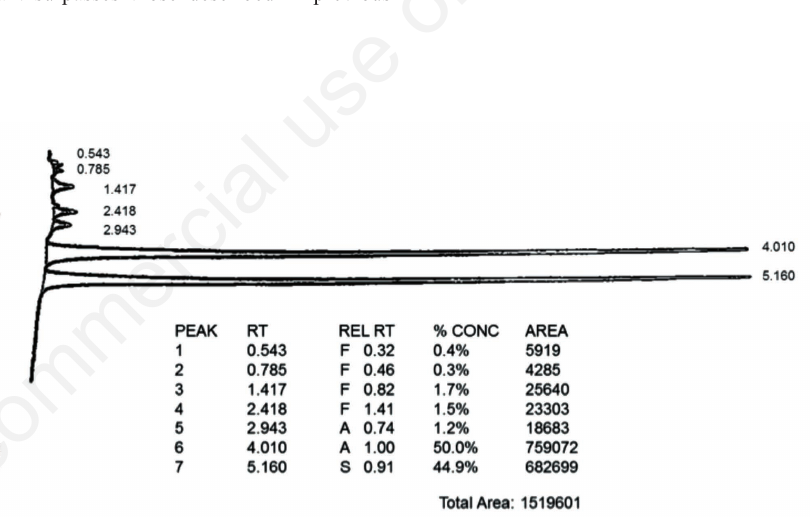
Figure 1. High-performance liquid chromatography demonstrating an abnormal peak that comprises approximately 44.9% of the total hemoglobin, consistent with an variant hemoglobin